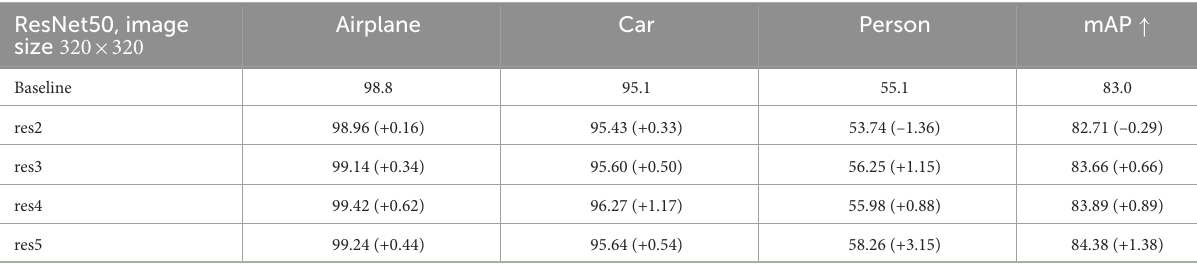
TABLE 1 Detection results on airport dataset by replacing the penultimate residual block of the different stages of Resnet50 backbone with the proposed M-DRF ( M = 8). ResNet50, image size 320